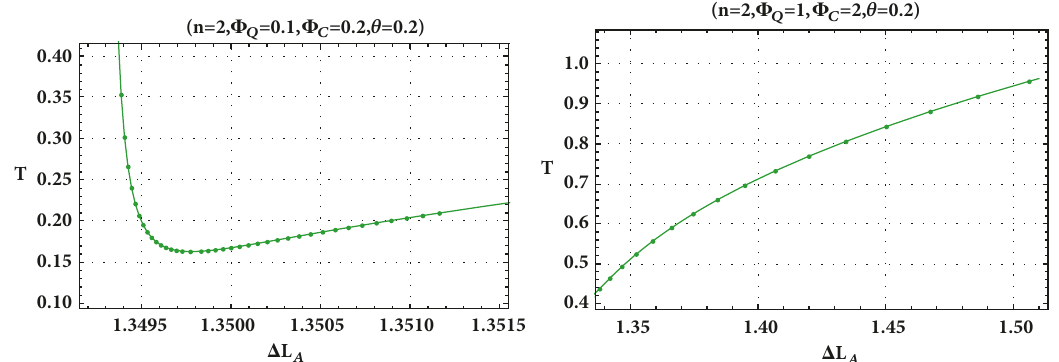
| for different 𝐶 . (Left) (Φ 𝑐